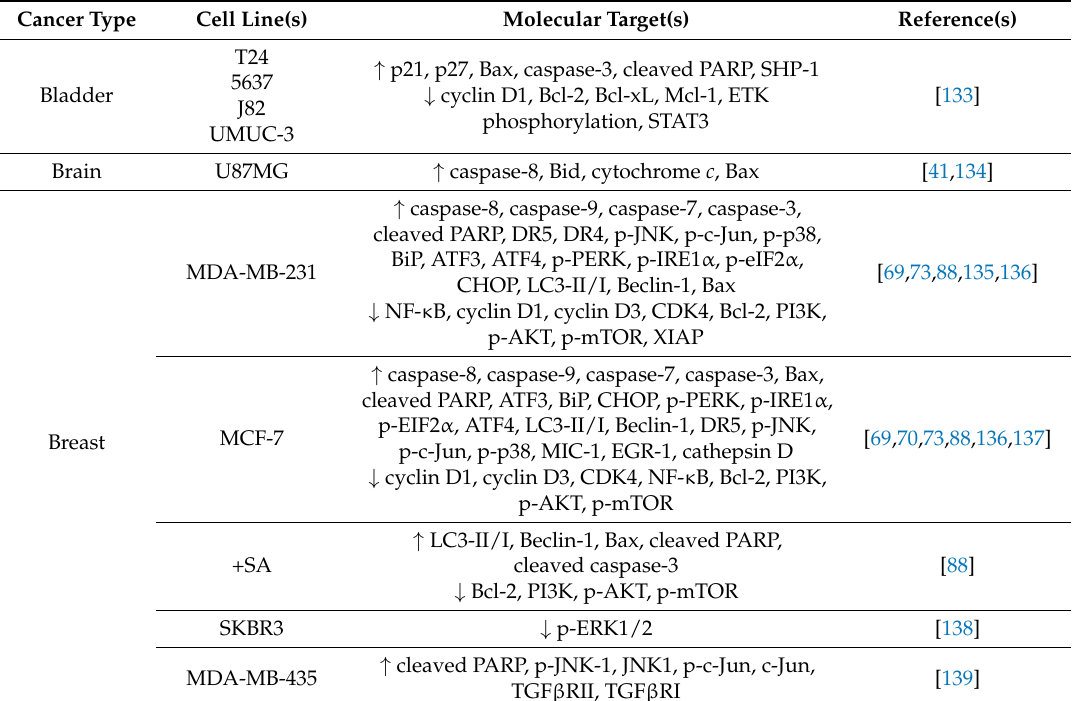
Table 1. Exemplar in vitro studies for elucidating the molecular targets of tocotrienols-induced cell